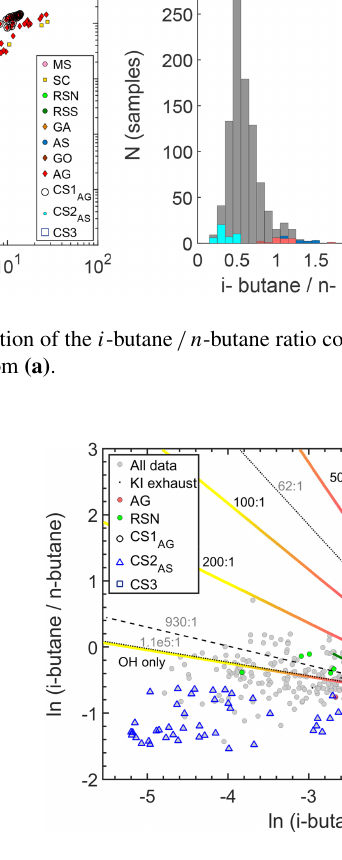
Figure 13. Observations of selected VOC tracer ratios ( i -butane, n -butane, propane) together with their expected evolution for OH and Cl oxidation from global emission ratios (yellow diamond). The dashed lines indicate the lowest (62 : 1), highest (1 . 1 × 10 5 : 1), and average (930 : 1) OH-to-Cl ratios derived from the EMAC